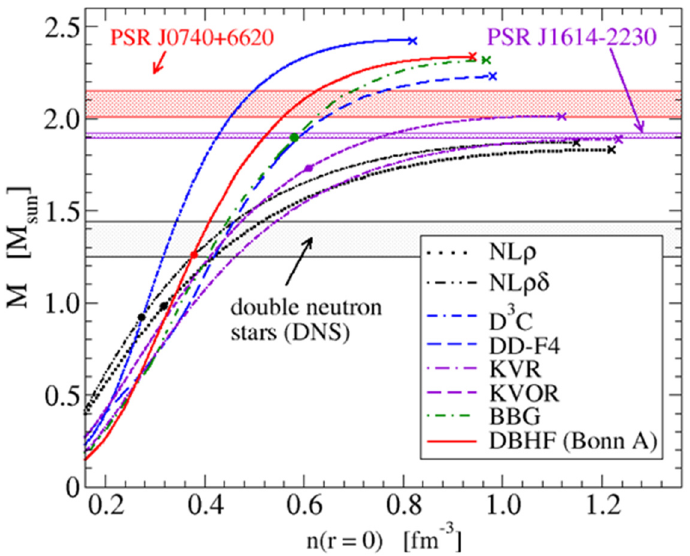
Figure 1. Neutron star mass versus central density for different EOS [1].